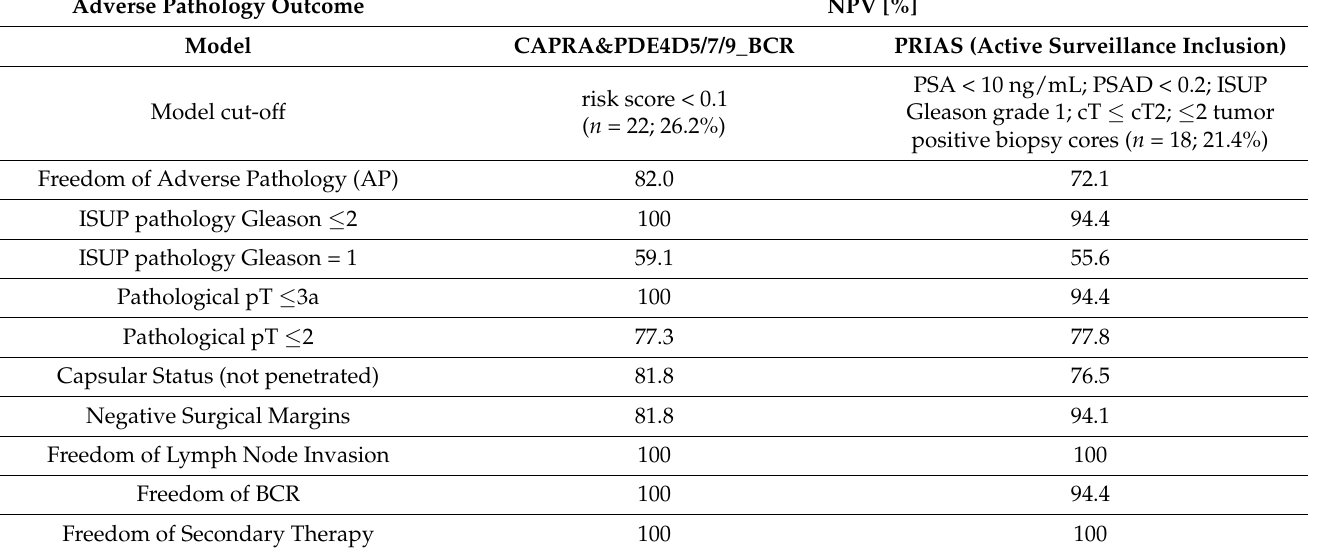
Table 5. Negative Predictive Value (NPV) of the CAPRA&PDE4D5/7/9_BCR and the PRIAS active surveillance inclusion model (low-to-intermediate-risk cohort; n = 84). The cut-off 0.1 was selected for the CAPRA&PDE4D5/7/9_BCR regression model which separates the patients into a low-risk group ( n = 22) vs. an intermediate–high-risk group ( n = 62). The inclusion criteria for PRIAS selects 18 patients with low risk vs. 66 patients with intermediate–high risk. The tested endpoints are indicated. PSAD–PSA density (ng/ng/mL). Adverse Pathology is defined as any ISUP pathological Gleason grade >2, or pathological pT stage > pT3a, or tumor penetrated prostate capsular status, or pN1 disease. BCR–biochemical recurrence after